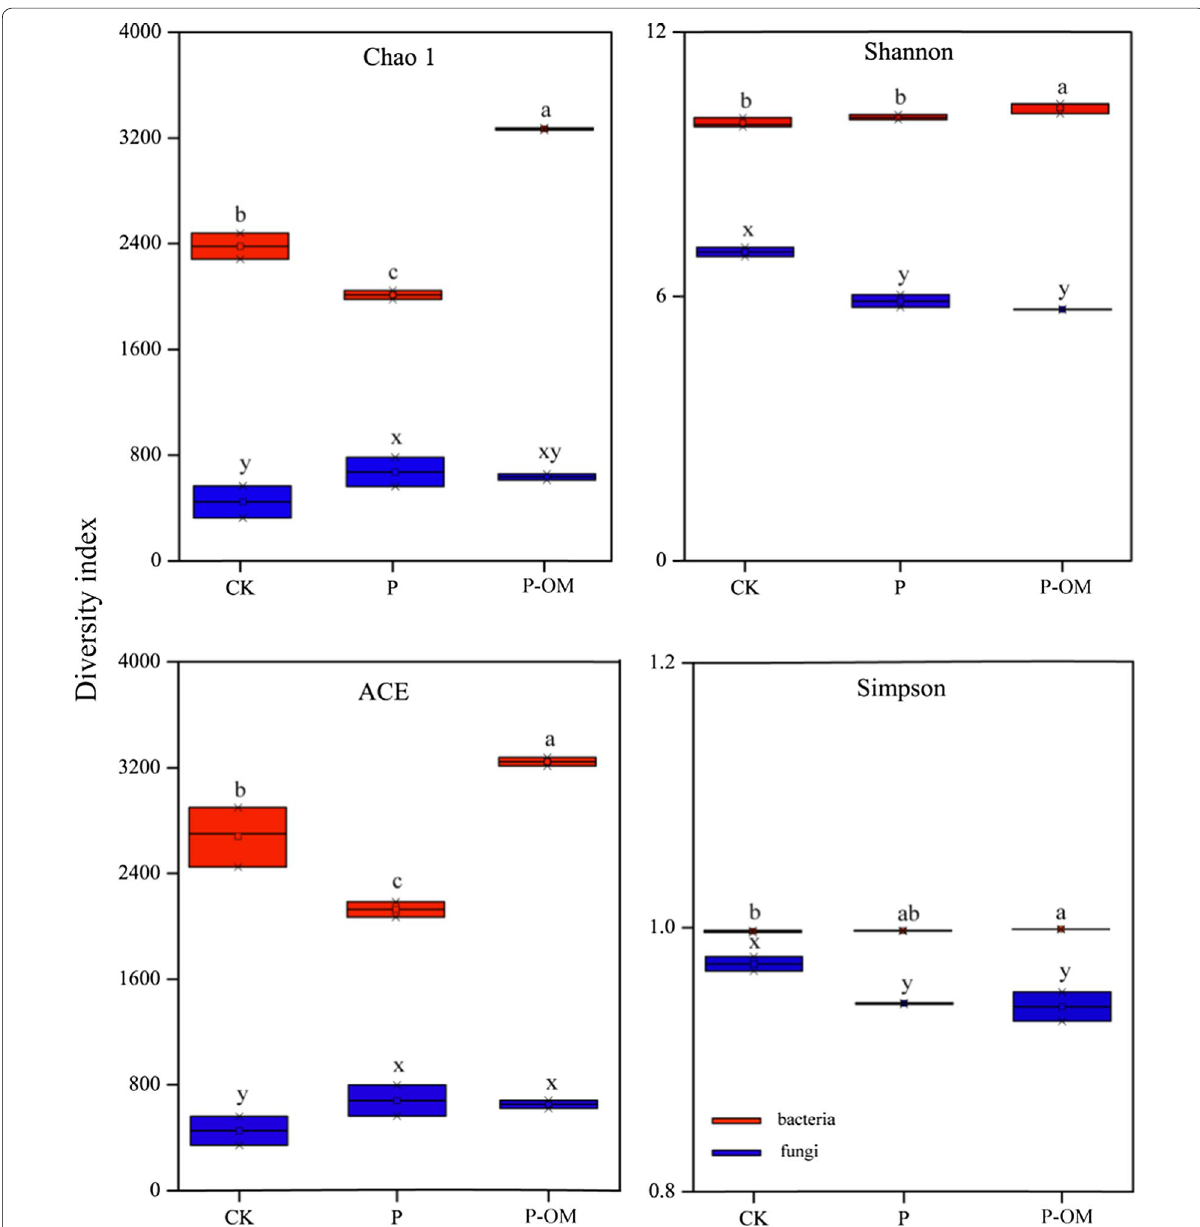
Fig. 2 α-diversity indexes of bacterial and fungi communities. Error bars represent standard errors of the triplicate analyses. Different letters indicate significant difference soil samples ( P <